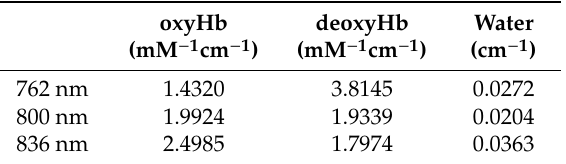
Table 1. Extinction coe ffi cients for oxyHb, deoxyHb, and water.